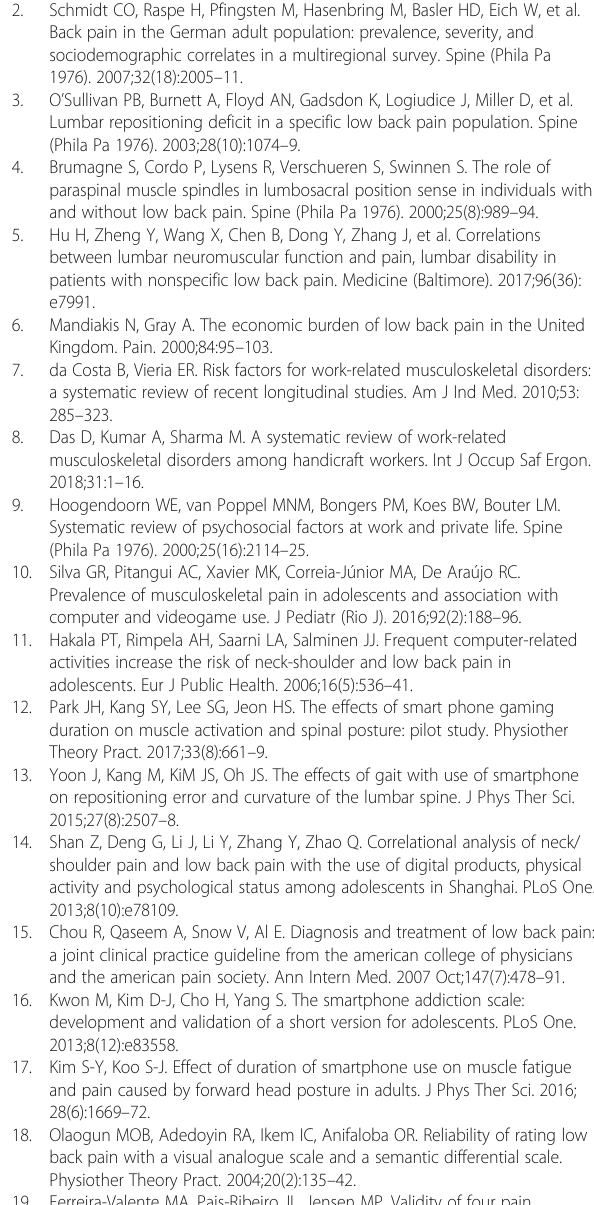
Additional file 1: Figure S1. A flow diagram showing subjects ’ selection, testing as well as data